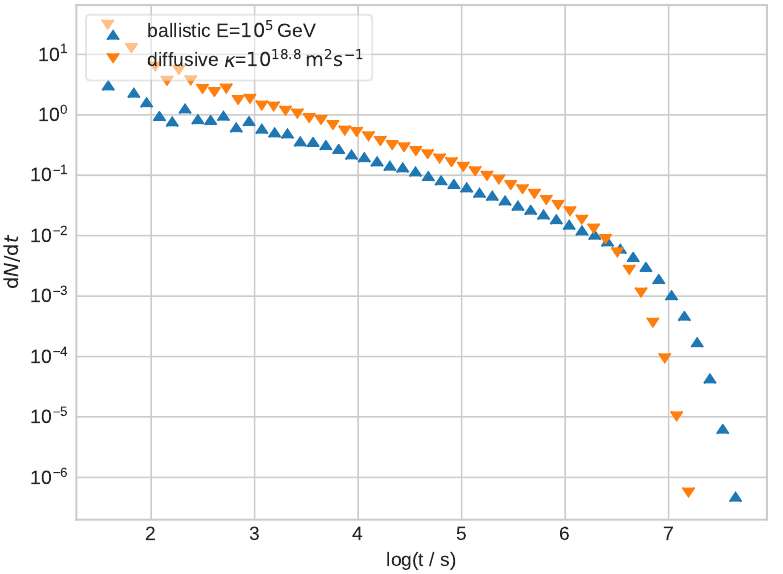
Figure 7. Cosmic-ray flare ( E = 10 5 GeV) from a blazar in the diffusive propagation model (orange downward triangle) and in the ballistic propagation model (blue upward triangle) as differential particle number per unit time, d N /d t , over time. The total number of particles injected into the simulation is N inj = 10 5 .